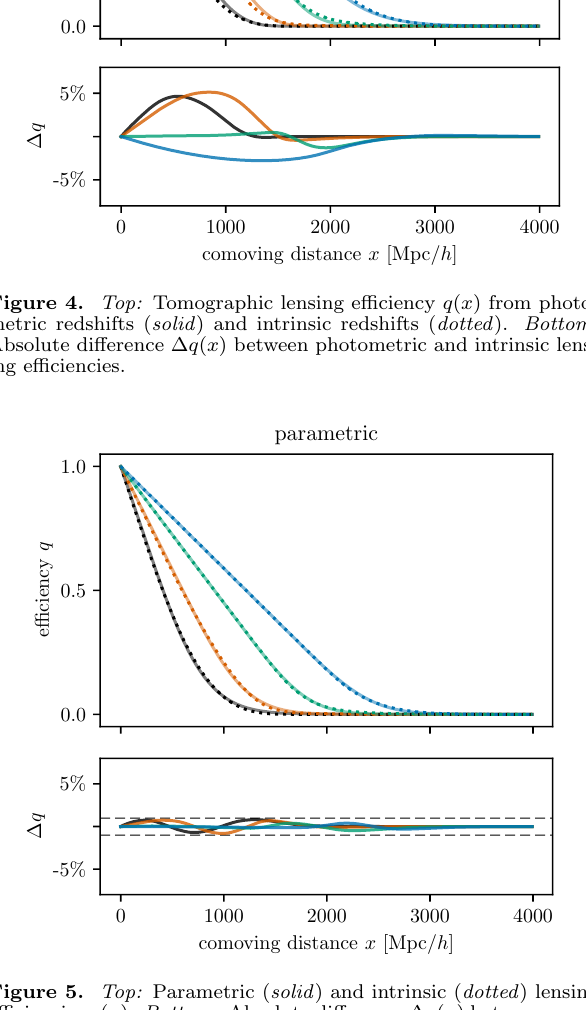
Figure 5. Top: Parametric ( solid ) and intrinsic ( dotted ) lensing efficiencies q ( x ). Bottom: Absolute difference ∆ q ( x ) between para- metric and intrinsic efficiencies. All curves lie inside the 1% band ( dashed